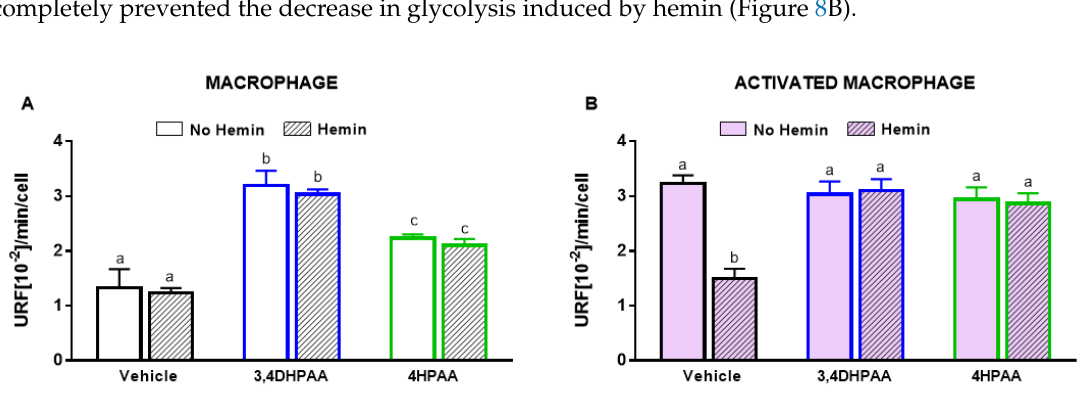
Figure 7. 3,4DHPAA and 4HPAA induce IP-10 release in macrophages and hemin reduces IP-10 release in macrophages. Levels of IP-10 in the media of ( A ) macrophages and ( B ) activated macrophages incubated with 10 μ M 3,4DHPAA or 10 μ M 4HPAA, in the presence or absence of 10 μ M hemin for 72 h. Values with different superscript letters (a and b) indicate significant differences ( p < 0.05) between groups. For all bars with the same letter, the difference between the means is not statistically significant. 3,4DHPAA, 3,4-dihydroxyphenylacetic acid; 4HPAA, 4-hydroxyphenylacetic acid; IP-10, interferon- γ -inducible protein 10.